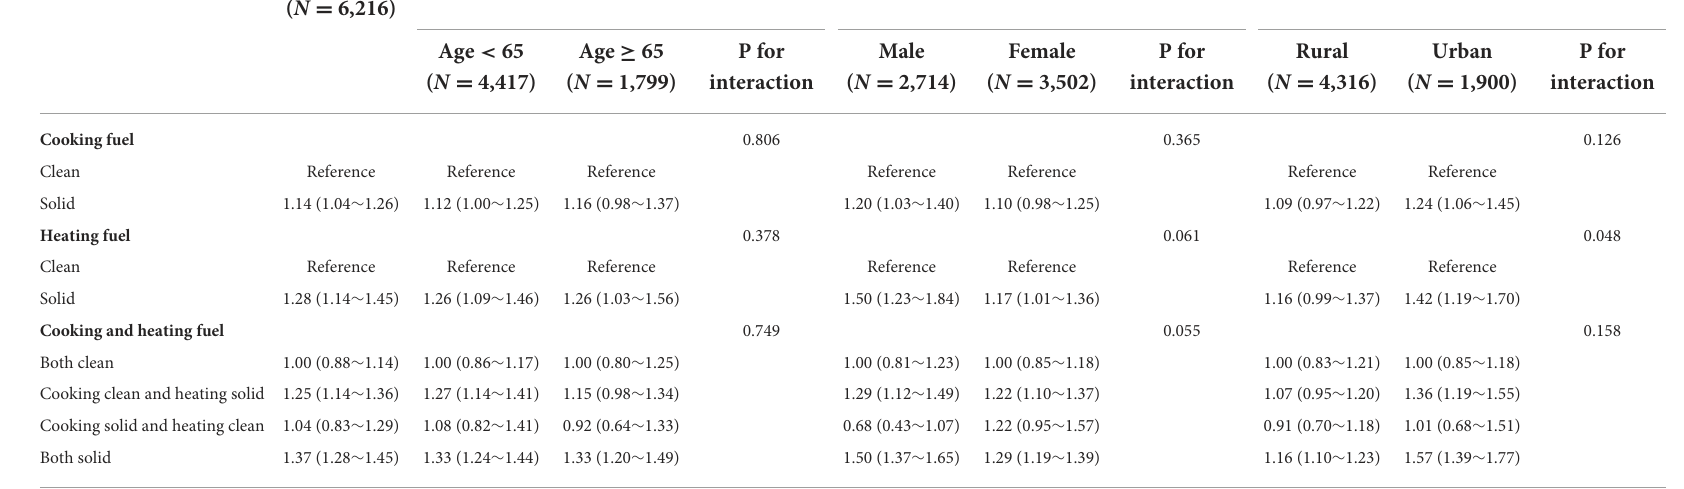
TABLE 1 HR (95% CI) of fuel usage with new-onset ADL disability: Cox proportional-hazards